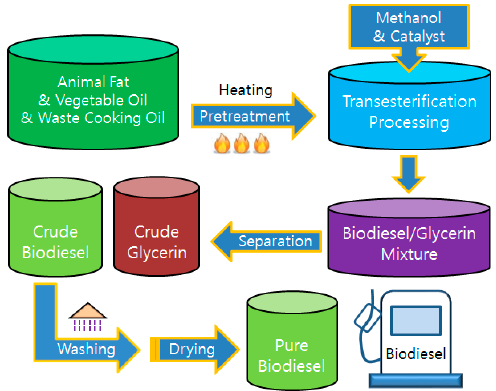
Figure 3. The specific process of transesterification method for biodiesel production.